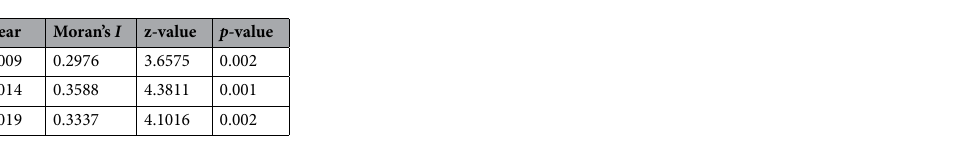
Table 4. Global Moran’s I and inspection of 62 city water ecological